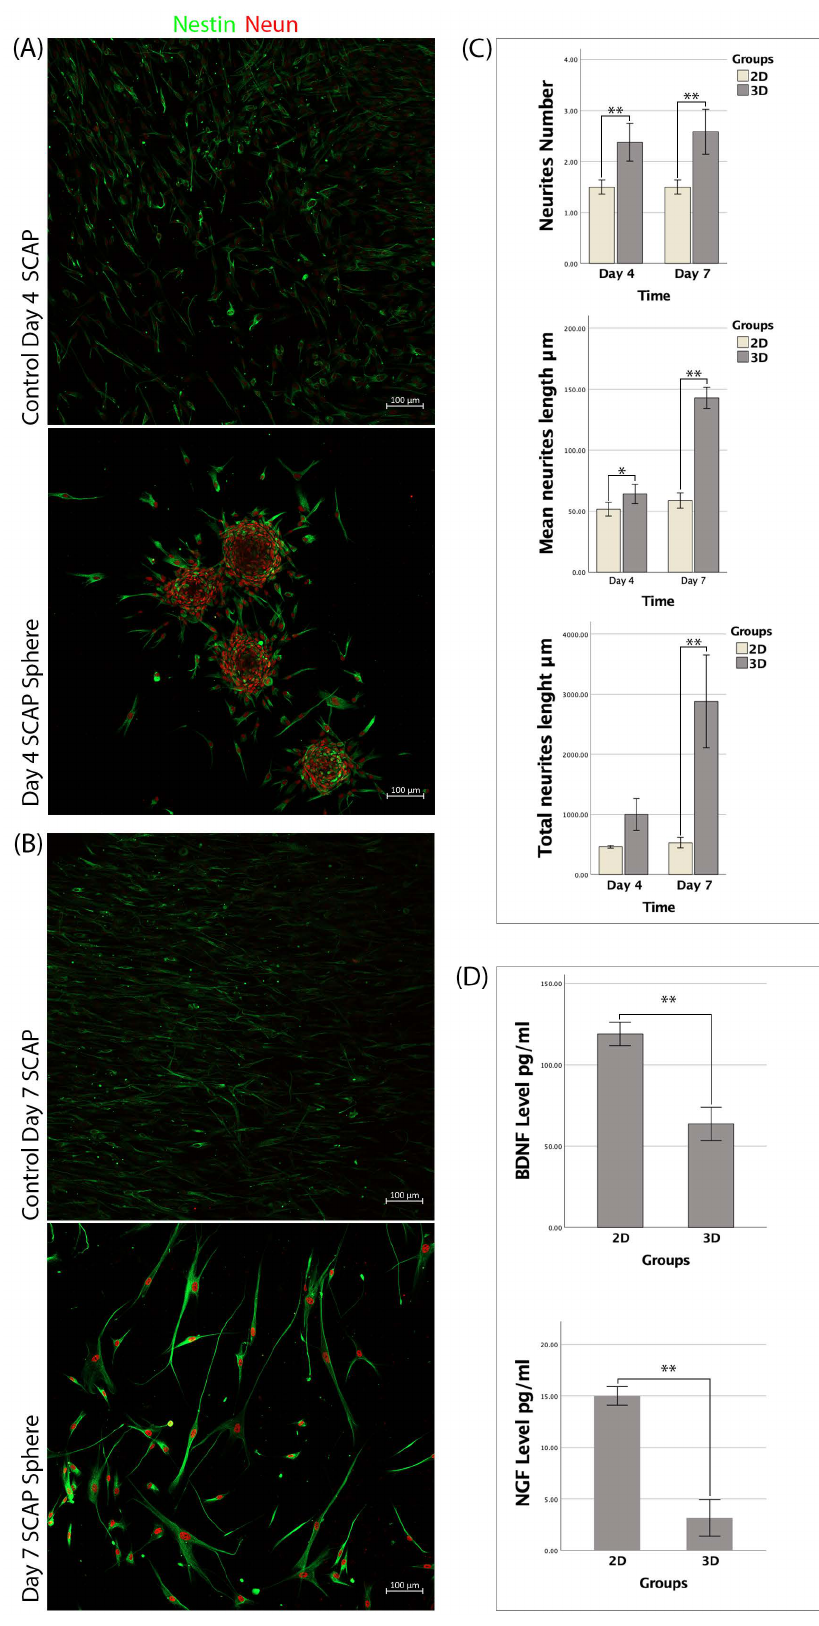
Figure 3. ( A , B ) Nestin and NeuN immunofluorescence staining showed changes in cell morphology on days 4 and 7; ( C ) Neurites’ number, mean length, and total length analysis, n = 8; ( D ) ELISA results for the expression of BDNF and NGF in pg/mL. Note (*: p < 0.05/**: p <